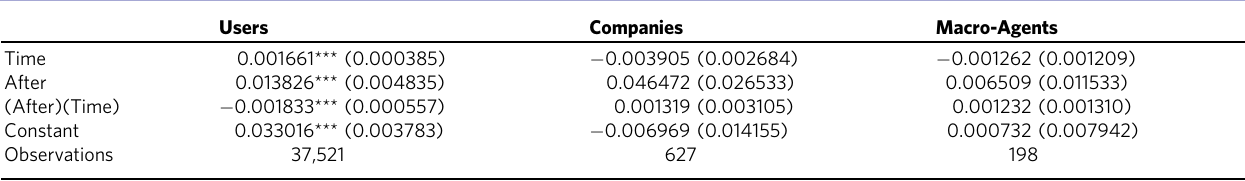
ThedependentvariableisthedegreetotendtoclusterperUsers,thedegreetotendtoclusterperCompanies,andthedegreetotendtoclusterperMacro-Agents.InColumnUsers,thesampleperiodis fromJanuary2015toDecember2017andconvertedto90-daytimespans(from − 14to + 18).InColumnCompanies,thesampleperiodisfromJanuary2015toDecember2017andconvertedto90-day time spans (from − 14 to + 18). In Column Macro-Agents, the sample period is from January 2015 to December 2017 and converted to 90-day time spans (from − 14 to + 18). Time span is 90-day time slices used to construct 90-day span network graphs. Time span 0 extends from 04-25-2016 to 05-24-2016 (i.e., the moment of the incentives policies). After is a dummy variable that equal 1 if time span is after the incentives policies and 0 otherwise. Newey-West robust standard errors are reported in brackets. *** p <0.01, ** p <0.05, * p